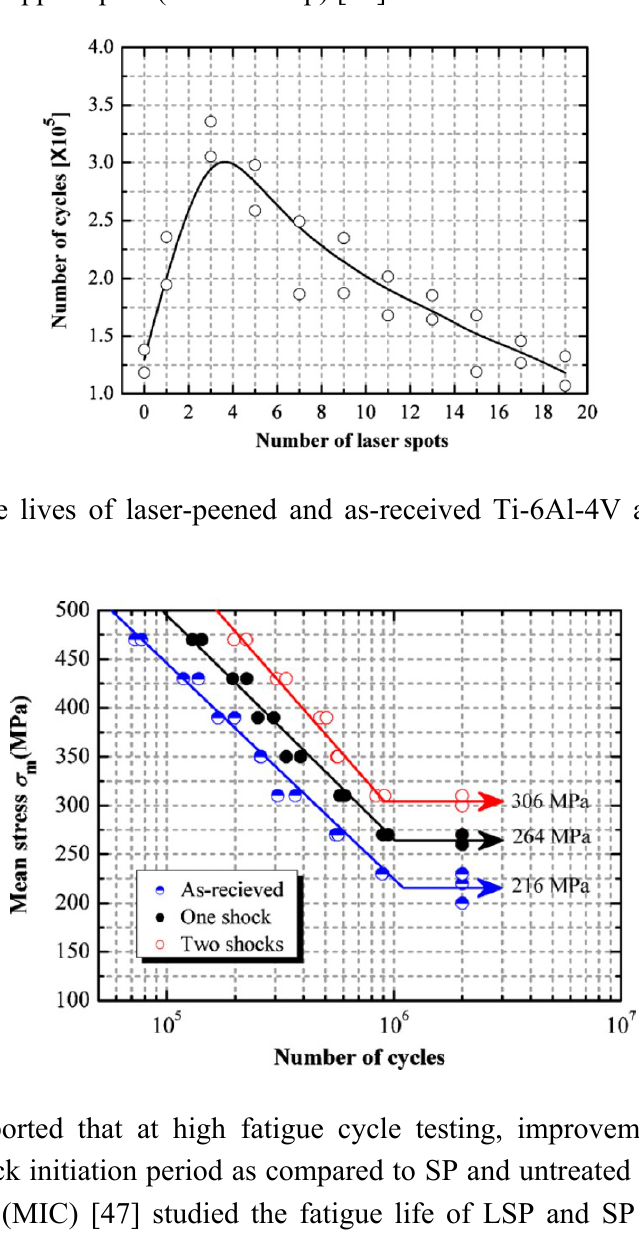
Figure 17. Variations of the fatigue lives with applied peak stress of 370 MPa along with the number of overlapped spots (40% overlap) [53].